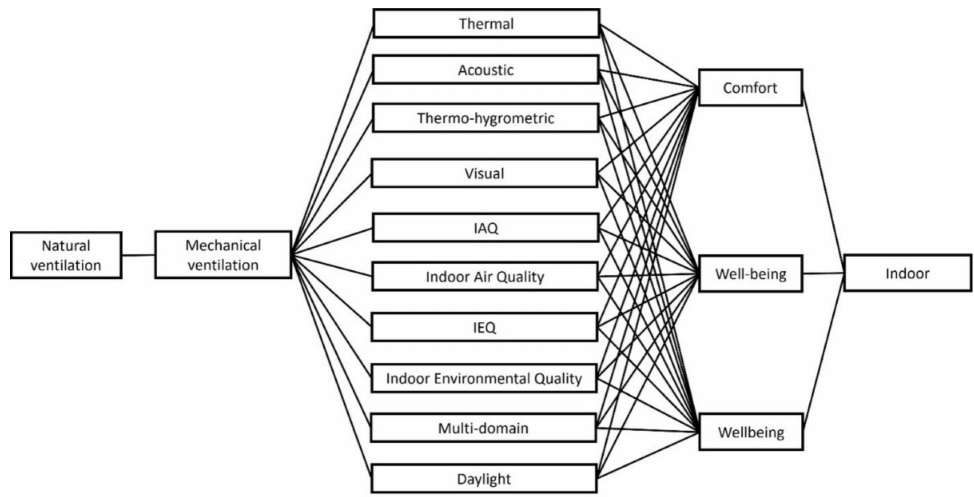
Figure 1. Boolean search string used for the first papers’ search query. Keywords on the same column were linked with the “OR” operator, while black lines represent the “AND”